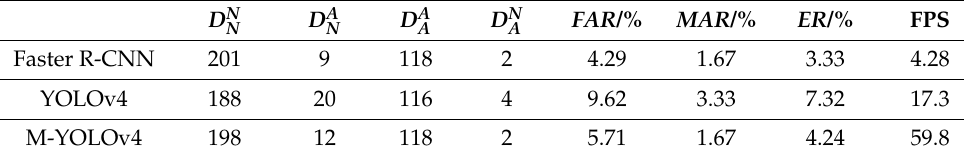
Table 1. Comparison of detection results between YOLOv4 and M-YOLOv4.